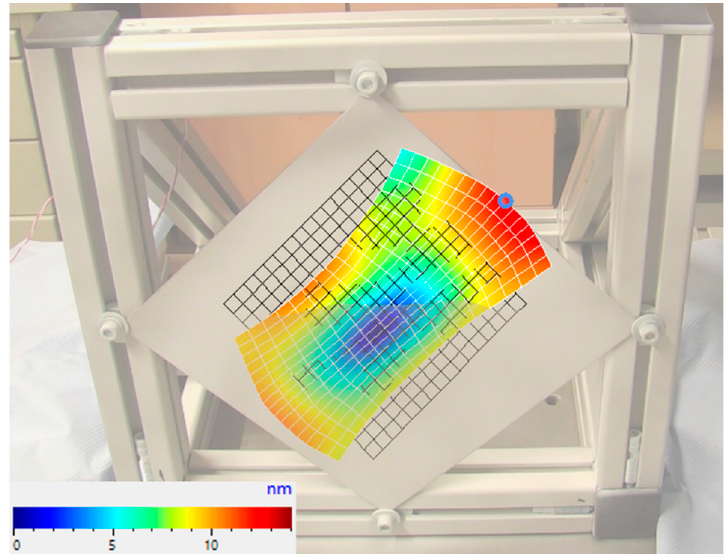
Figure 7. In-plane vibration mode at 11.23 kHz. Table 2. Offsets and noise of the individual sensors.